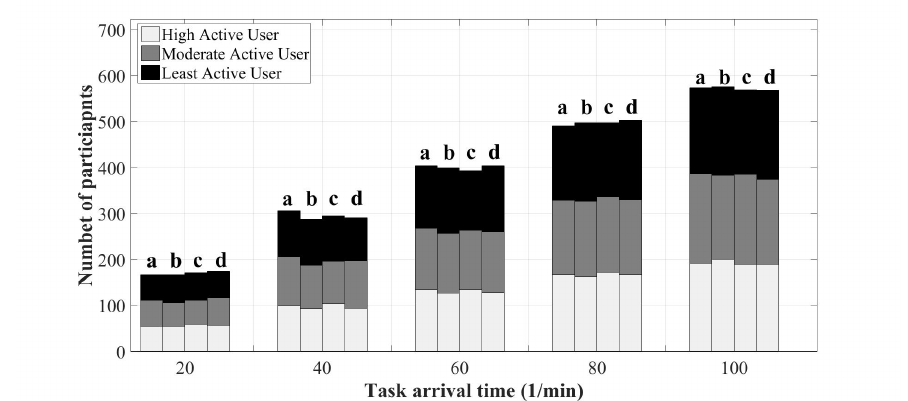
Figure 13. User participation in different scenarios: ( a ) mobile crowd-sensing benchmark; ( b ) SOBER-MCS with (cid:60) = 10%; ( c ) SOBER-MCS with (cid:60) = 15%; and ( d ) SOBER-MCS with (cid:60) =